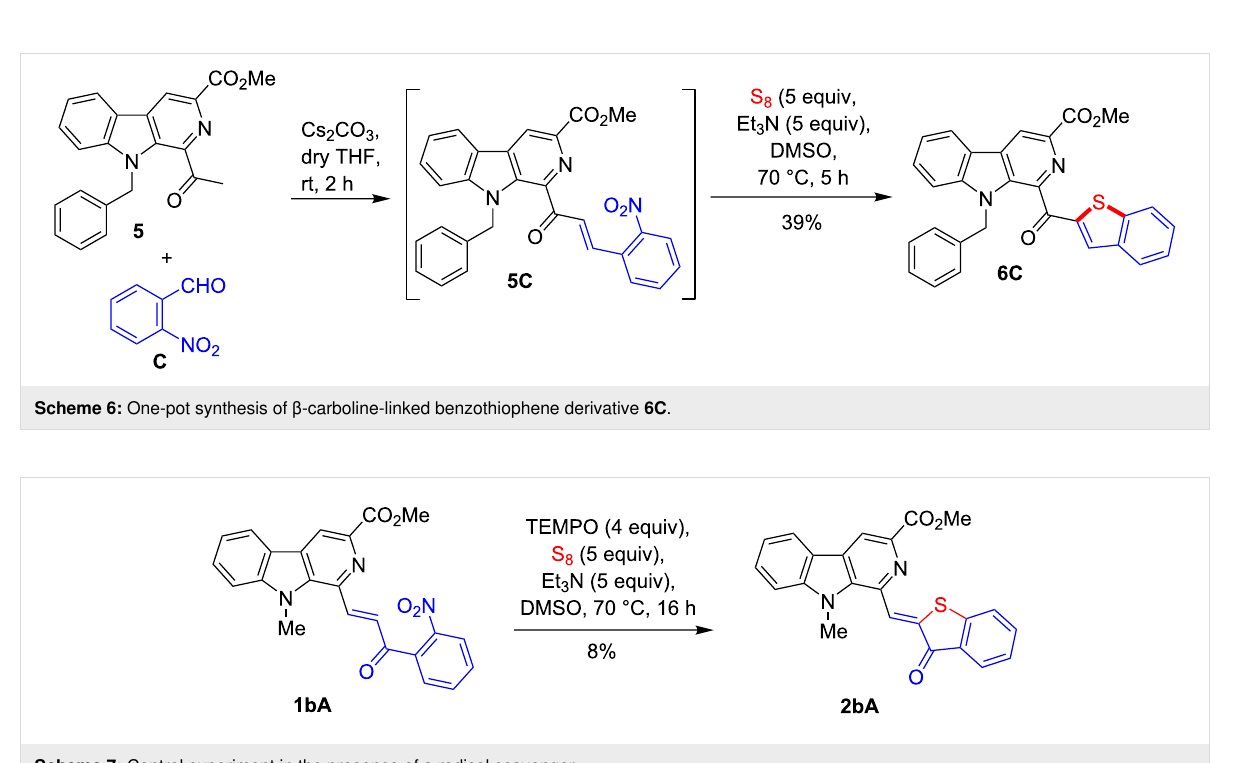
occurs via the reaction of elemental sulfur with triethylamine